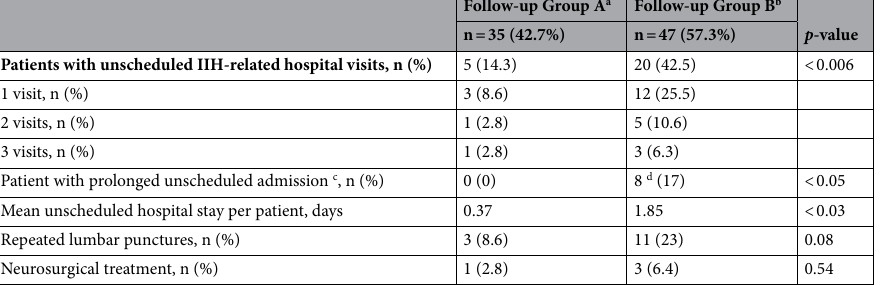
Follow-up Group A a Follow-up Group B b